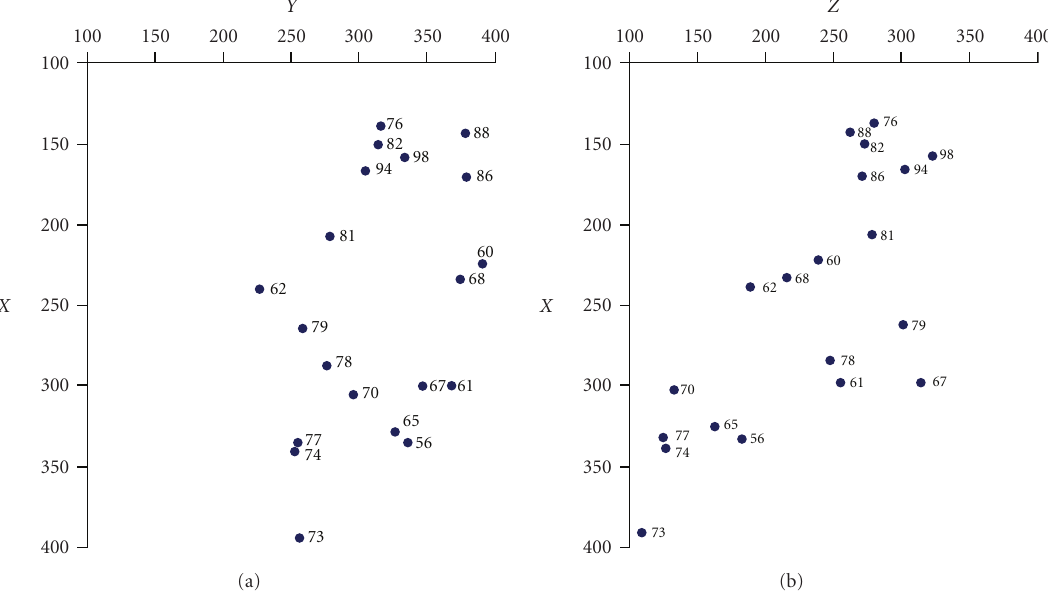
Figure 10: 2D pixel coordinates for 20 locations visited by mapping tip-electrode in left ventricle as seen in the posterior and left lateral images. Isochronal times are tagged at the 20